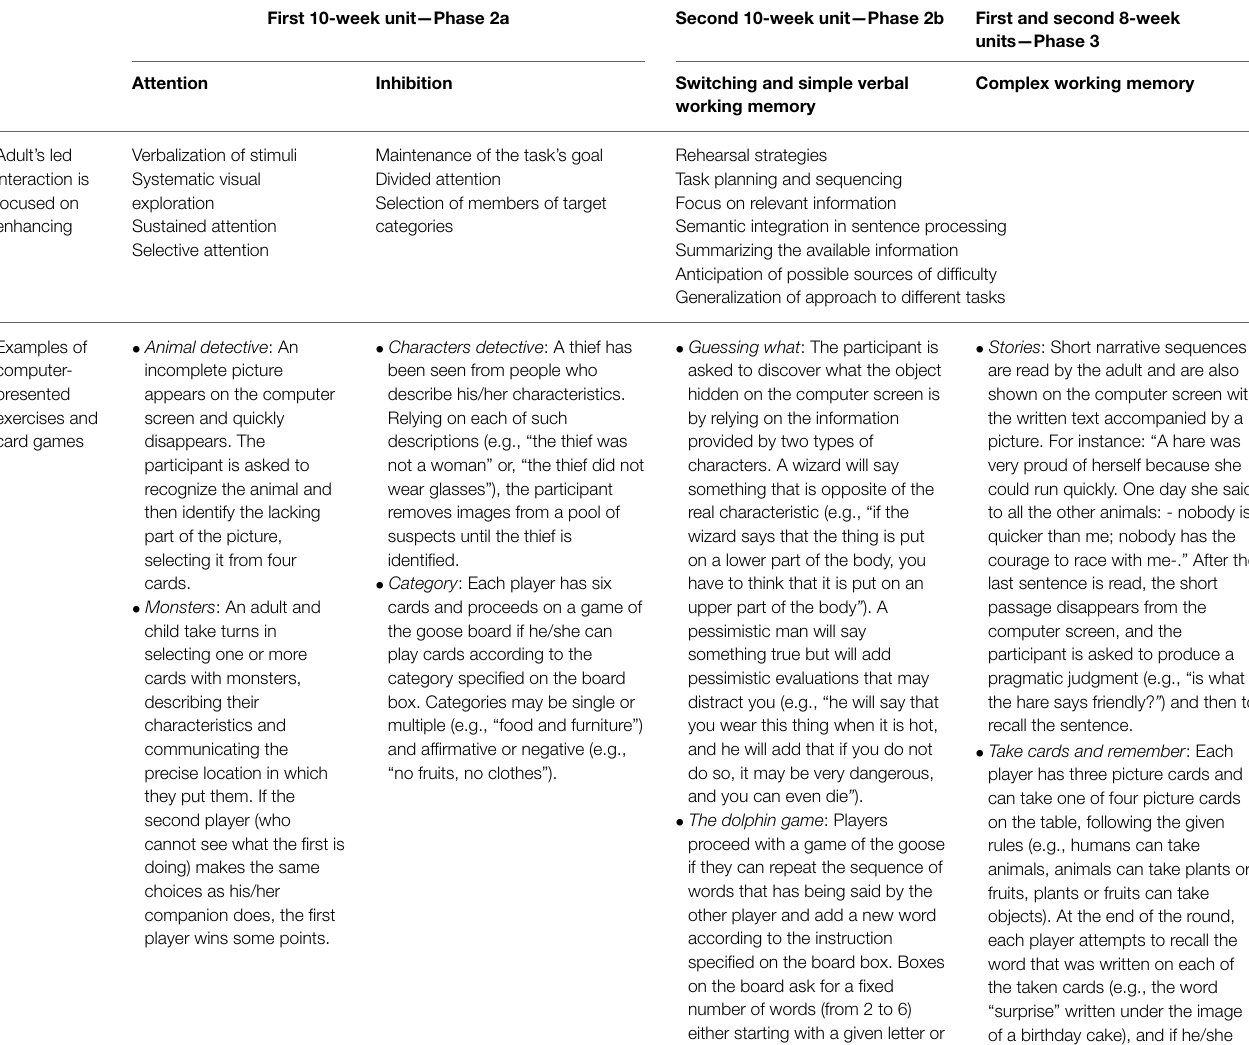
TABLE 2 | Phases of the cognitive training